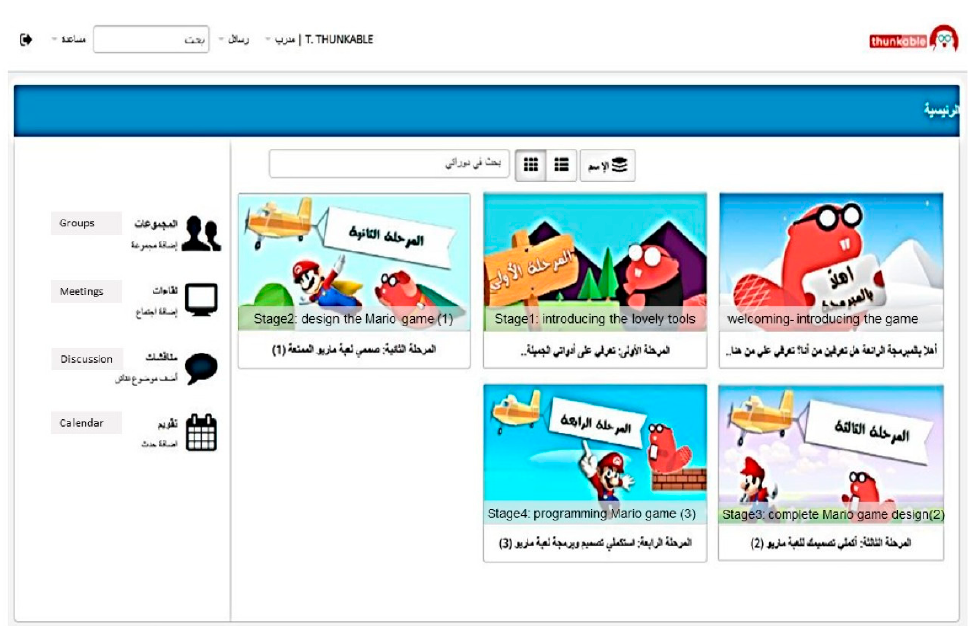
Figure 3. Main TalentLMS interface showing the orientation stage and subsequent four learning stages